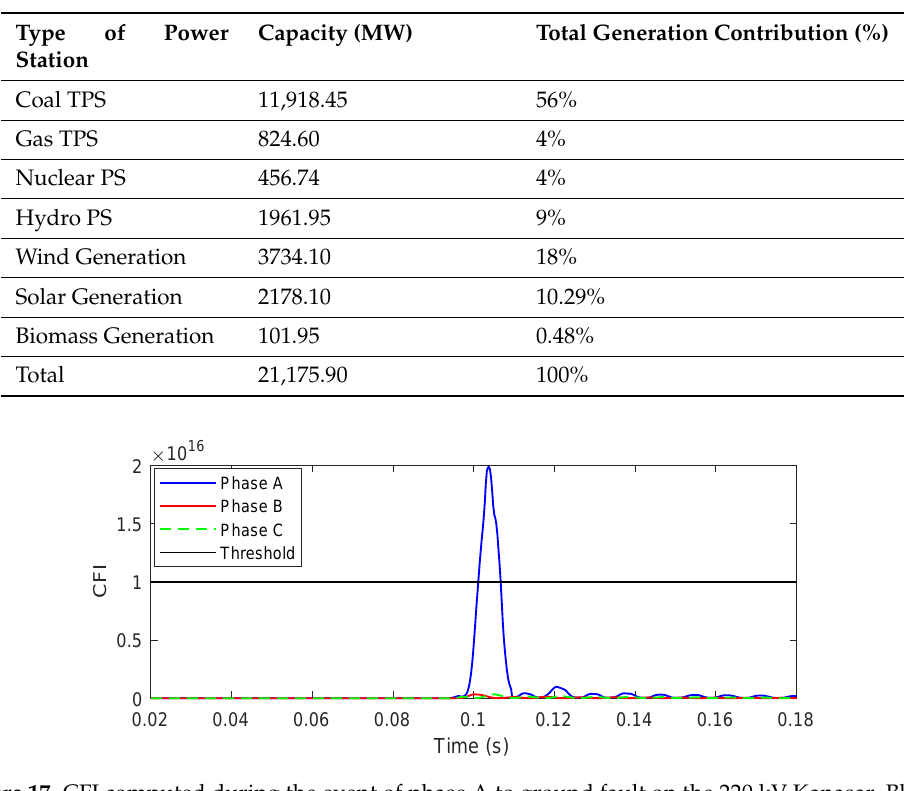
Figure 17. CFI computed during the event of phase A to ground fault on the 220 kV Kanasar–Bhadla line of practical power system network of Rajasthan State of